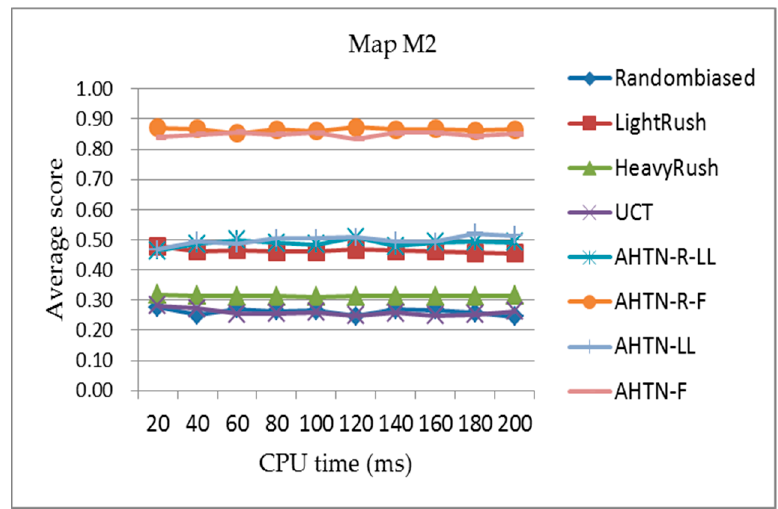
Figure 8. The average score of each algorithm obtained over the 800 games of the round-robin competition for map M2 (12 × 12 tiles) with respect to the CPU time from 20 to 200 ms. The playout time is 100 cycles.